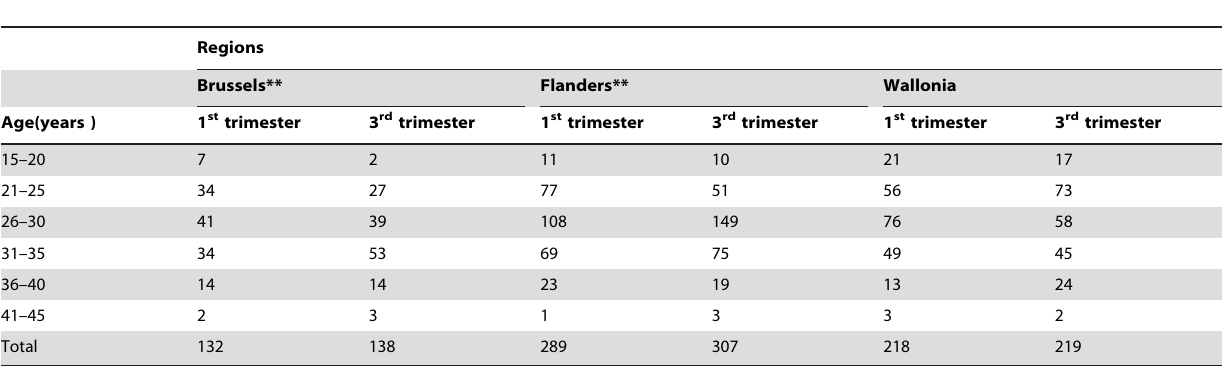
Table 1. Number of pregnant women by region, trimester and age (national survey on vitamin D status among pregnant women Belgium, 2010–2011).